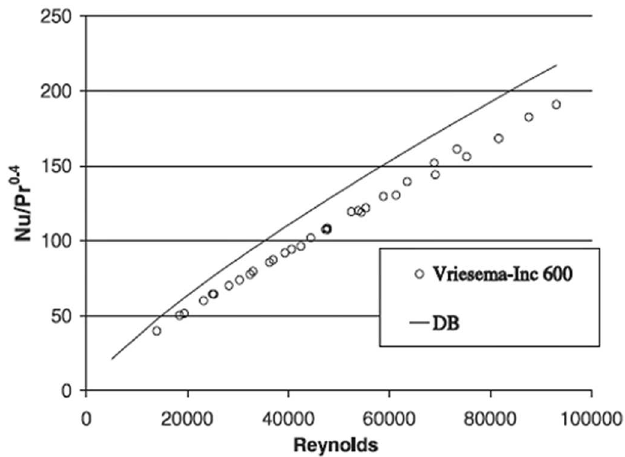
Fig. 2. Experimental results obtained by Vriesema [4] compared with Dittus